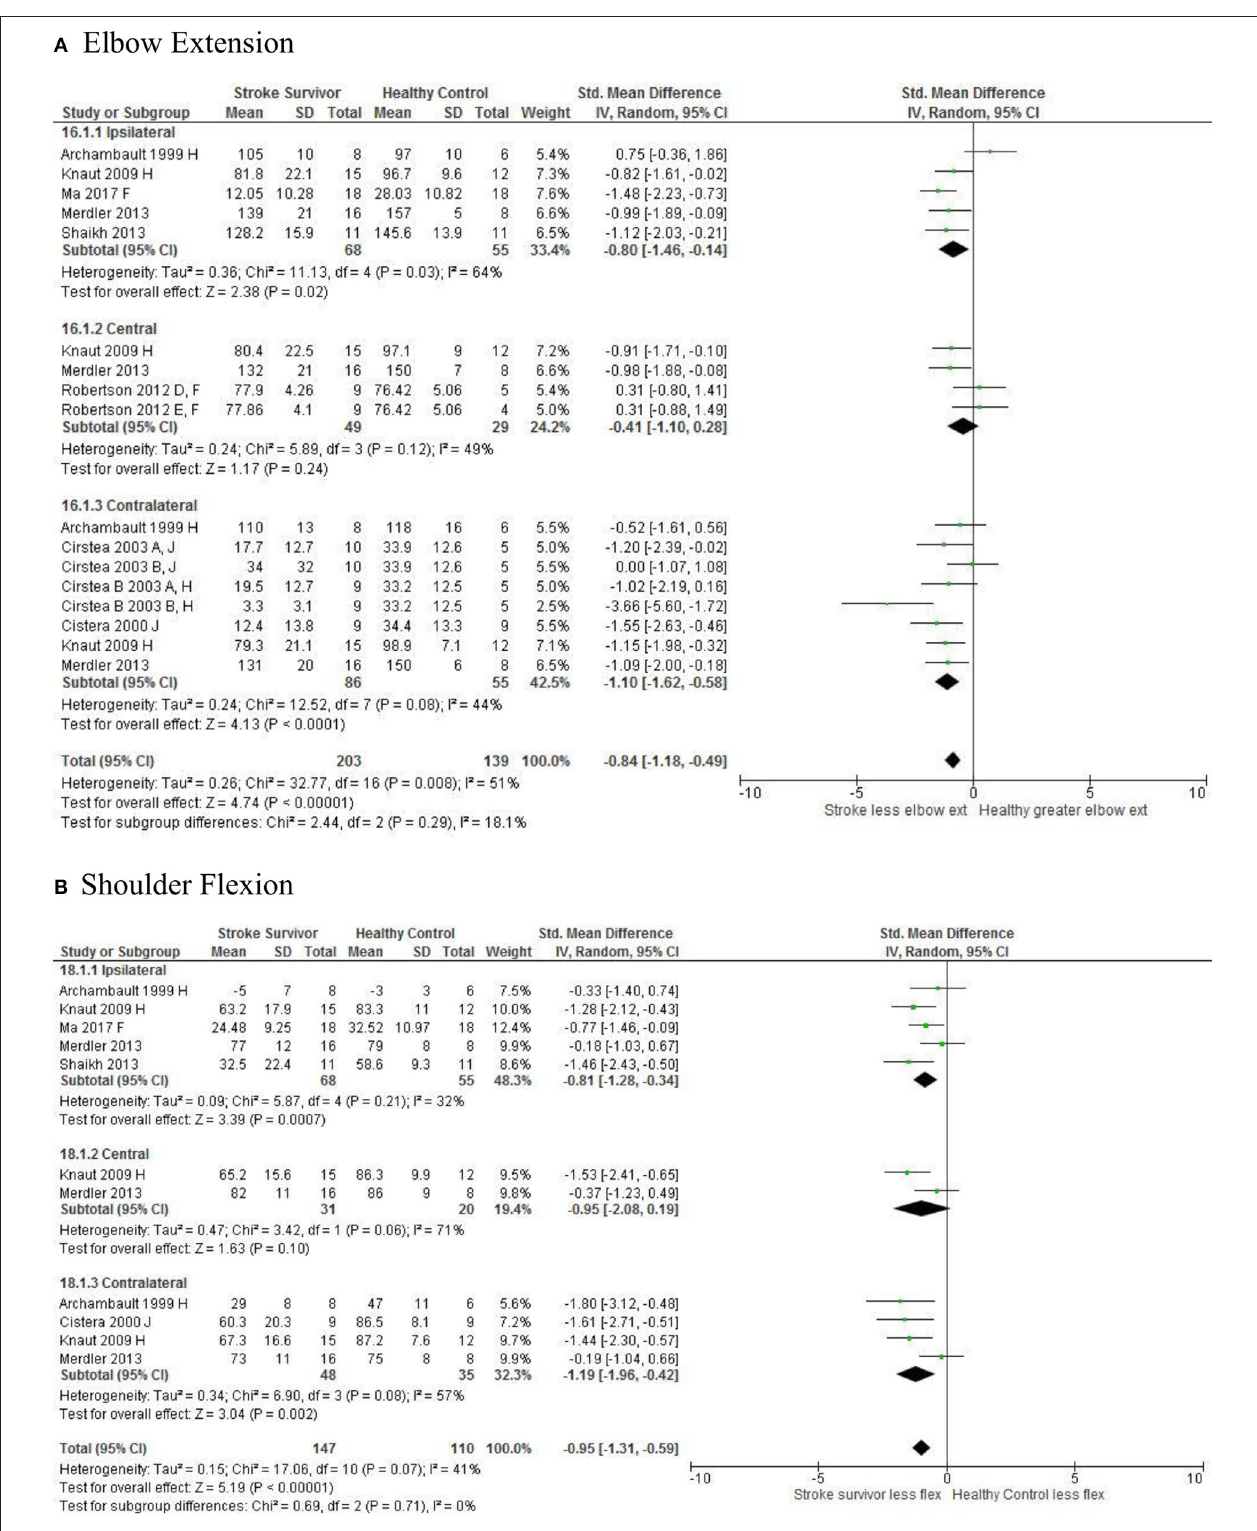
FIGURE 7 | The standardized mean difference (SDM) of joint kinematics in the ipsilateral, central, and contralateral workspace. D, right hemisphere stroke; E, left hemisphere stroke; F, target at 90% of arm’s length; H, fast speed; J, reaches without vision.